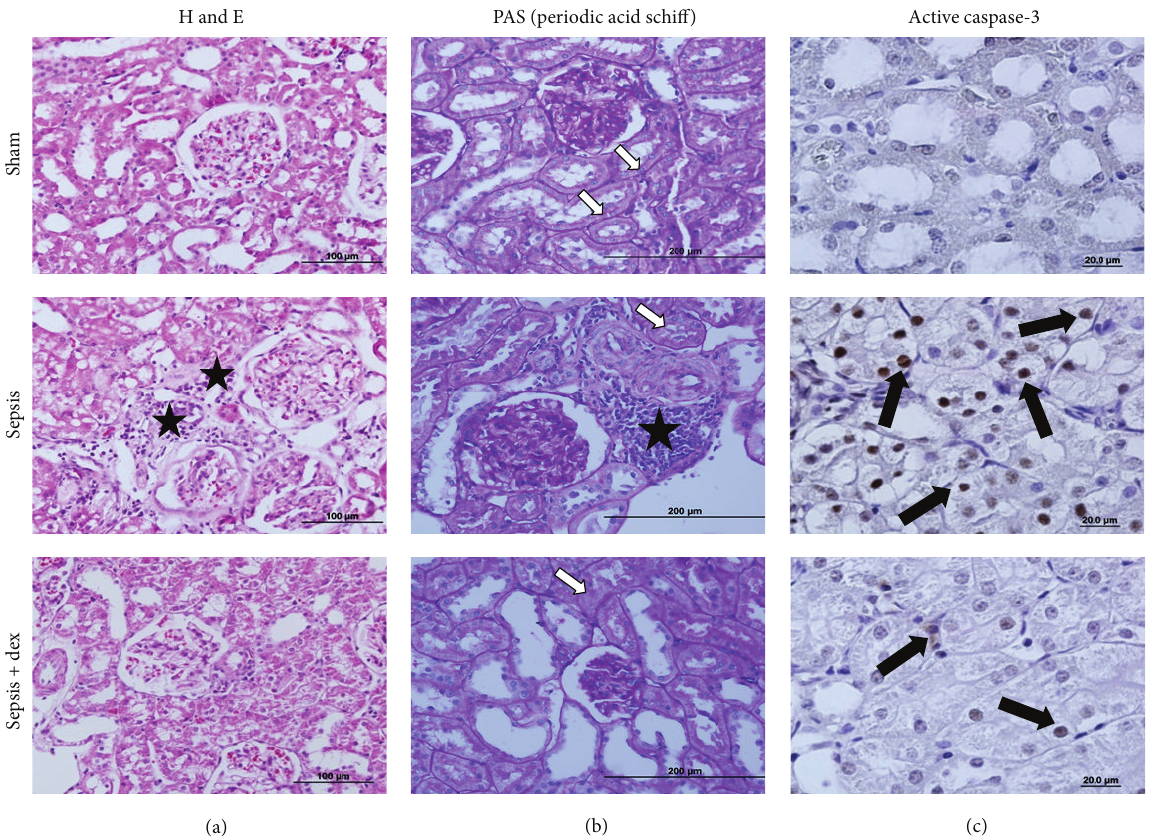
Figure 10: Representative histochemical and immunohistochemical staining in kidney tissue (H and E, PAS, and active caspase-3) micrographs of experimental groups. (a) represented H&E, (b) PAS, and (c) represented active caspase-3 immunohistochemistry stained sections. ( 󳀅 ) showed mononuclear cell infiltration; (white arrows) resembled basal represented membrane regularity and brush border in proximal tubule endothelium; (black arrows) represented active caspase-3 positive